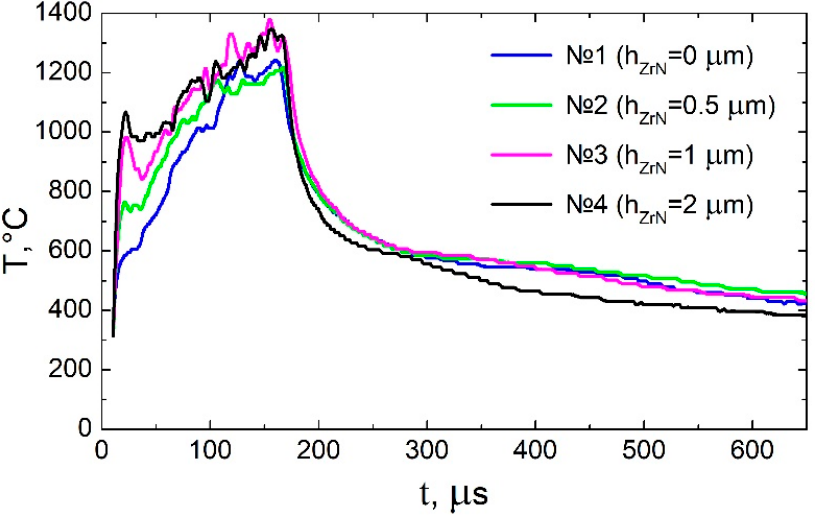
Figure 6. Time variations of the local surface temperature during electron beam treatment for the bare and ZrN-coated silumin samples.